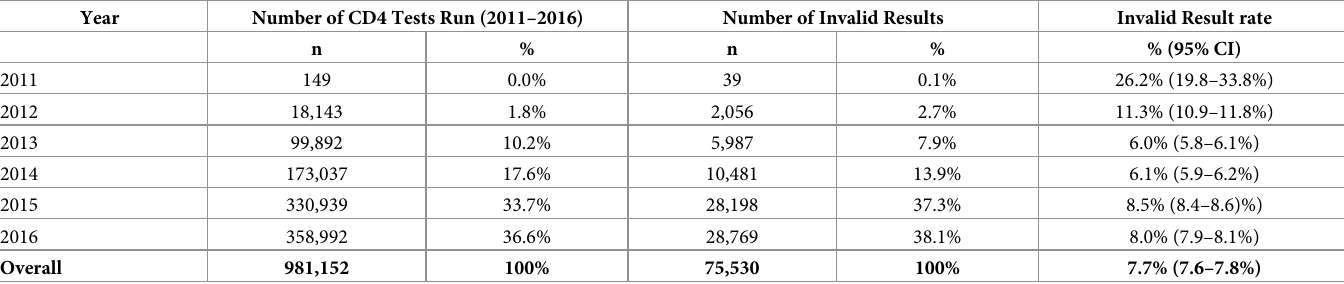
Table 2. Pima CD4 testing volumes and invalid results per